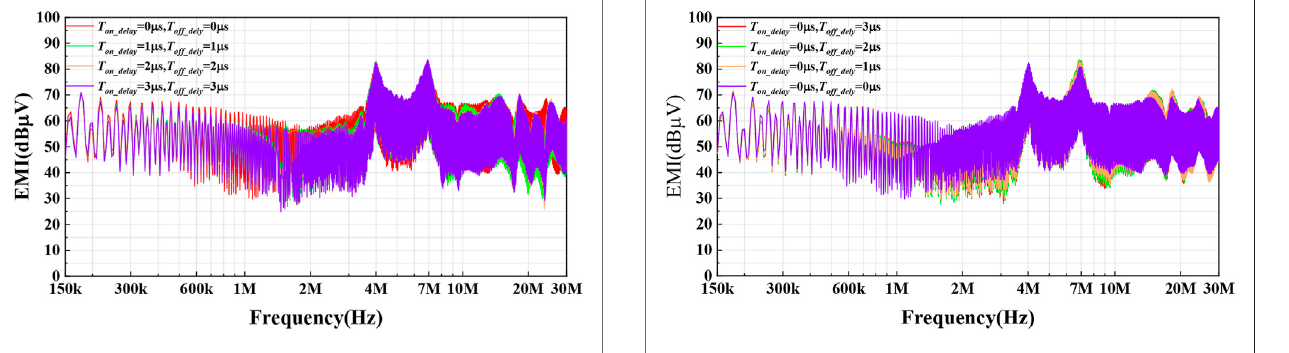
FIGURE 12 | Test results of CM EMI at different T off_delay (pattern